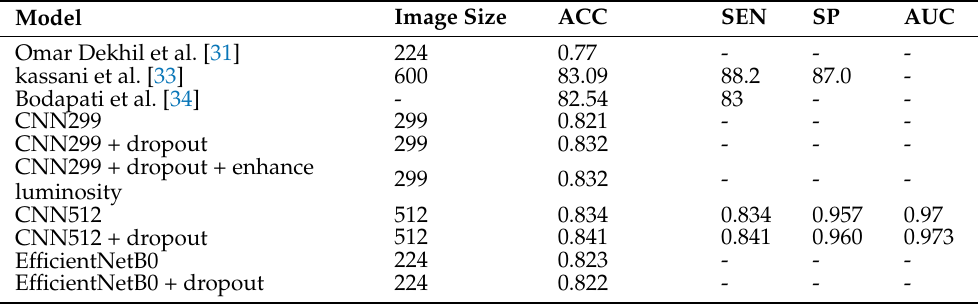
Table 11. Comparison between the proposed models and the state of-art models on the APTOS 2019